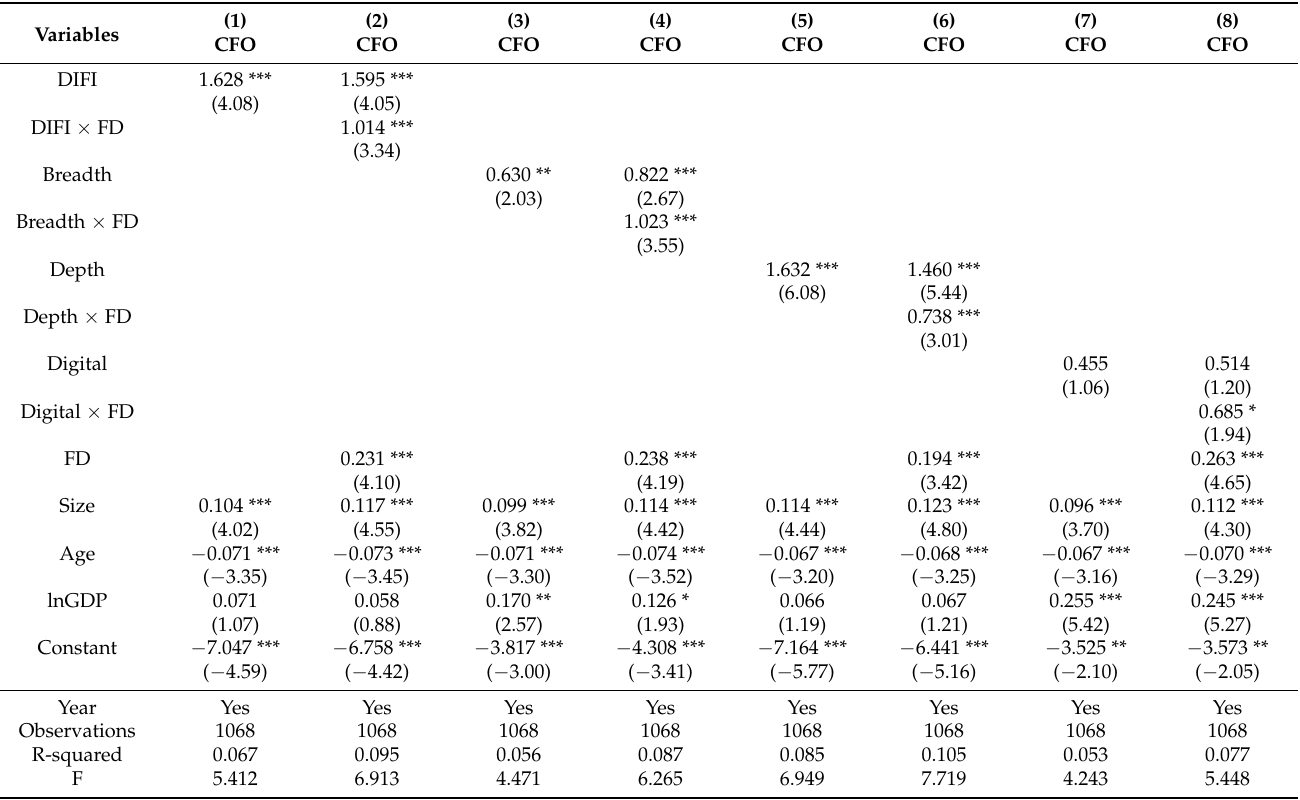
Table A2. Robustness test of moderating effect with substitute dependent variable.